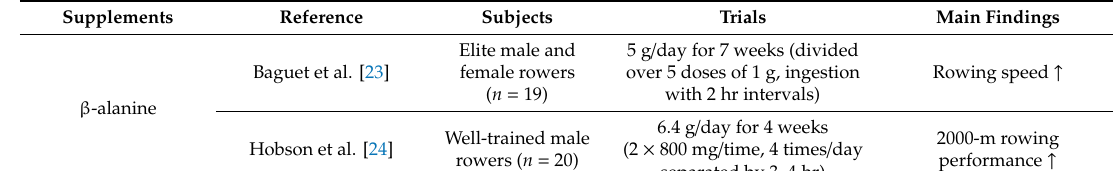
Table 2. E ff ect of performance enhancing supplements on rowing